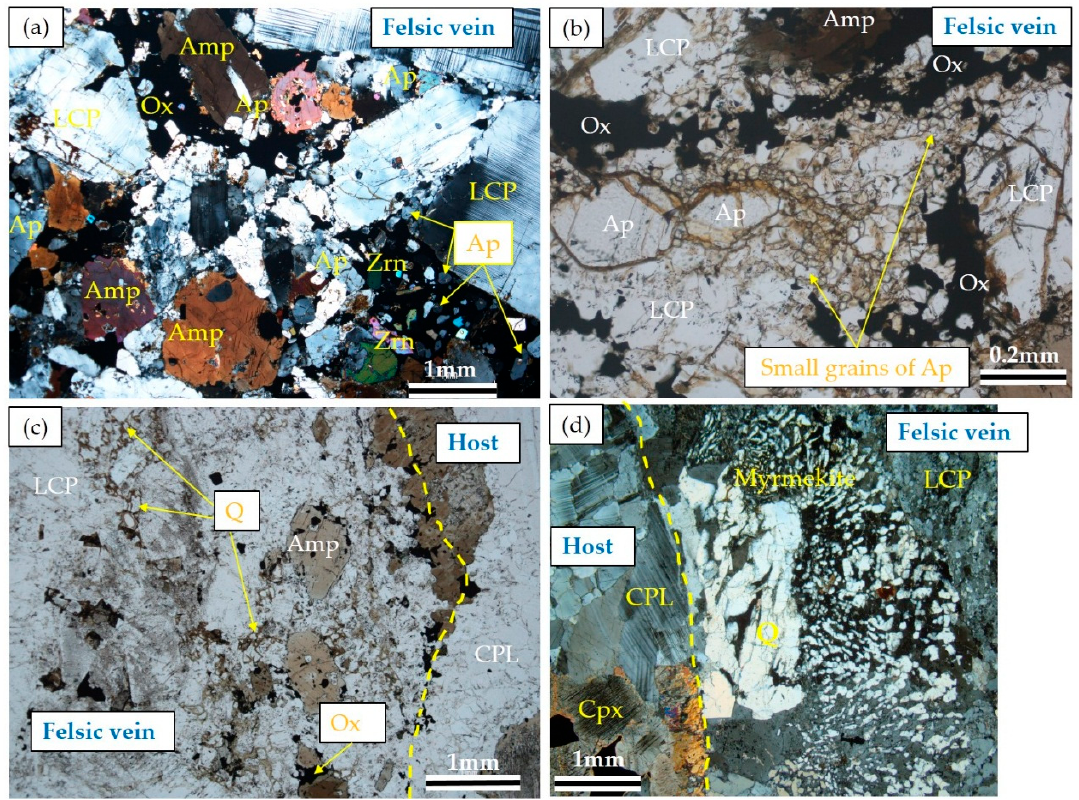
Figure 9. Photomicrographs of felsic vein Hole U1473A. ( a ) Sample 41R2, 26–31 cm; notice the abundance of Fe–Ti oxide, zircon, and apatite. ( b ) Sample 41R2, 26–31 cm; small grains of apatite in fine-grained part in felsic vein. ( c ) Sample 64R2, 128–133 cm; interstitial quartz in the center of the felsic vein. ( d ) Sample 41R3, 73–76 cm; the myrmekitic texture of quartz and plagioclase. Amp: Amphibole. CPL: Calcic plagioclase. LCP: Less calcic plagioclase. Ox: Fe–Ti oxide. Q: Quartz. Ap: Apatite. Zrn: Zircon.